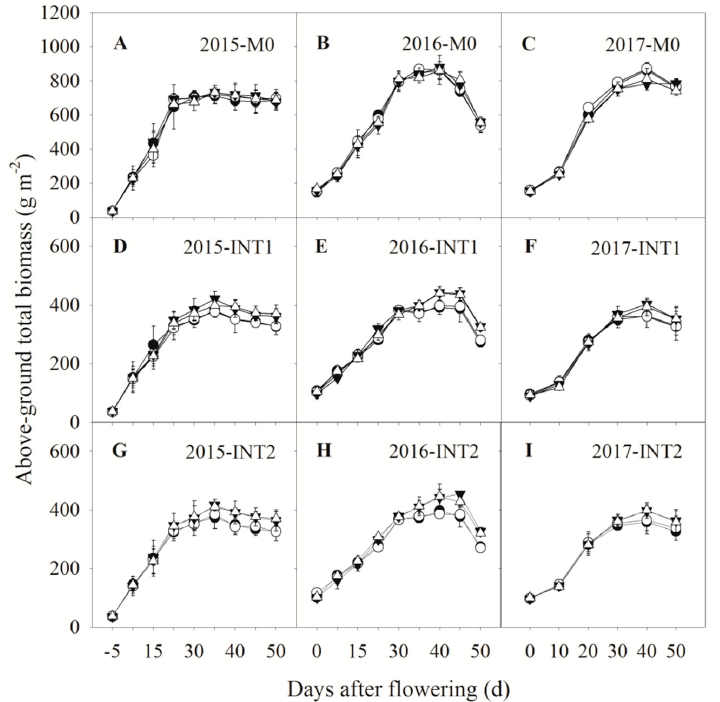
Figure 6. Dynamic changes of above-ground total biomass for the di ff erent soybean cultivars ( ● : HD19; ○ : HD20; ▼ : ZH39 and △ : QH34) under different planting patterns ( A , B and C for M0; D , E and F for INT1; G , H and I for INT2, respectively) at the days after flowering during 2015–2017. Each value is the mean ( n = 3) ±